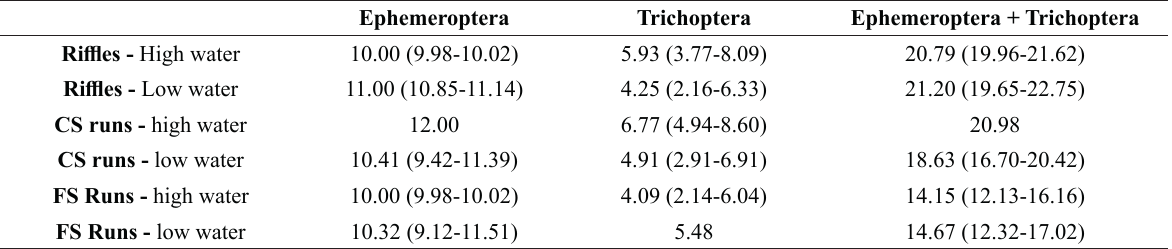
Mean expected number of species with 95% confidence intervals. Rarefaction 1000 permutations, minimum Ephemeroptera: CS Runs – high water = 9901; Trichoptera: FS Runs –low water = 31; Ephemeroptera + Trichoptera: CS